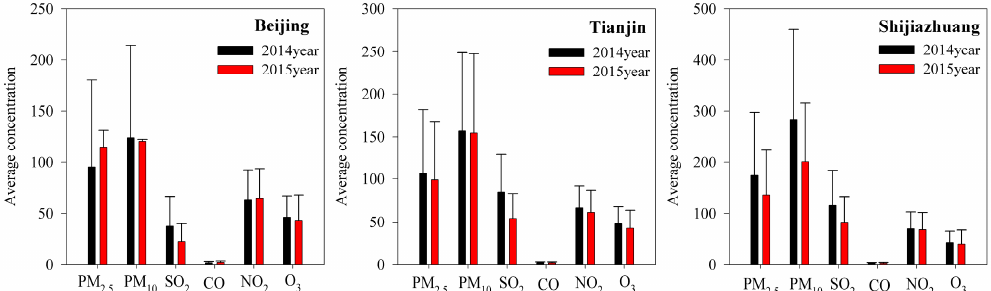
Figure 5. The average concentration of the principal air pollutants in Beijing-Tianjin-Hebei during January, February, November, and December (2014 and 2015). Units: PM 2.5 ( μ g/m − 3 ), PM 10 ( μ g/m − 3 ), CO (mg/m − 3 ), SO 2 ( μ g/m − 3 ), NO 2 ( μ g/m − 3 ), and O 3 ( μ g/m − 3 ). Atmosphere 2017 , 8 , 137